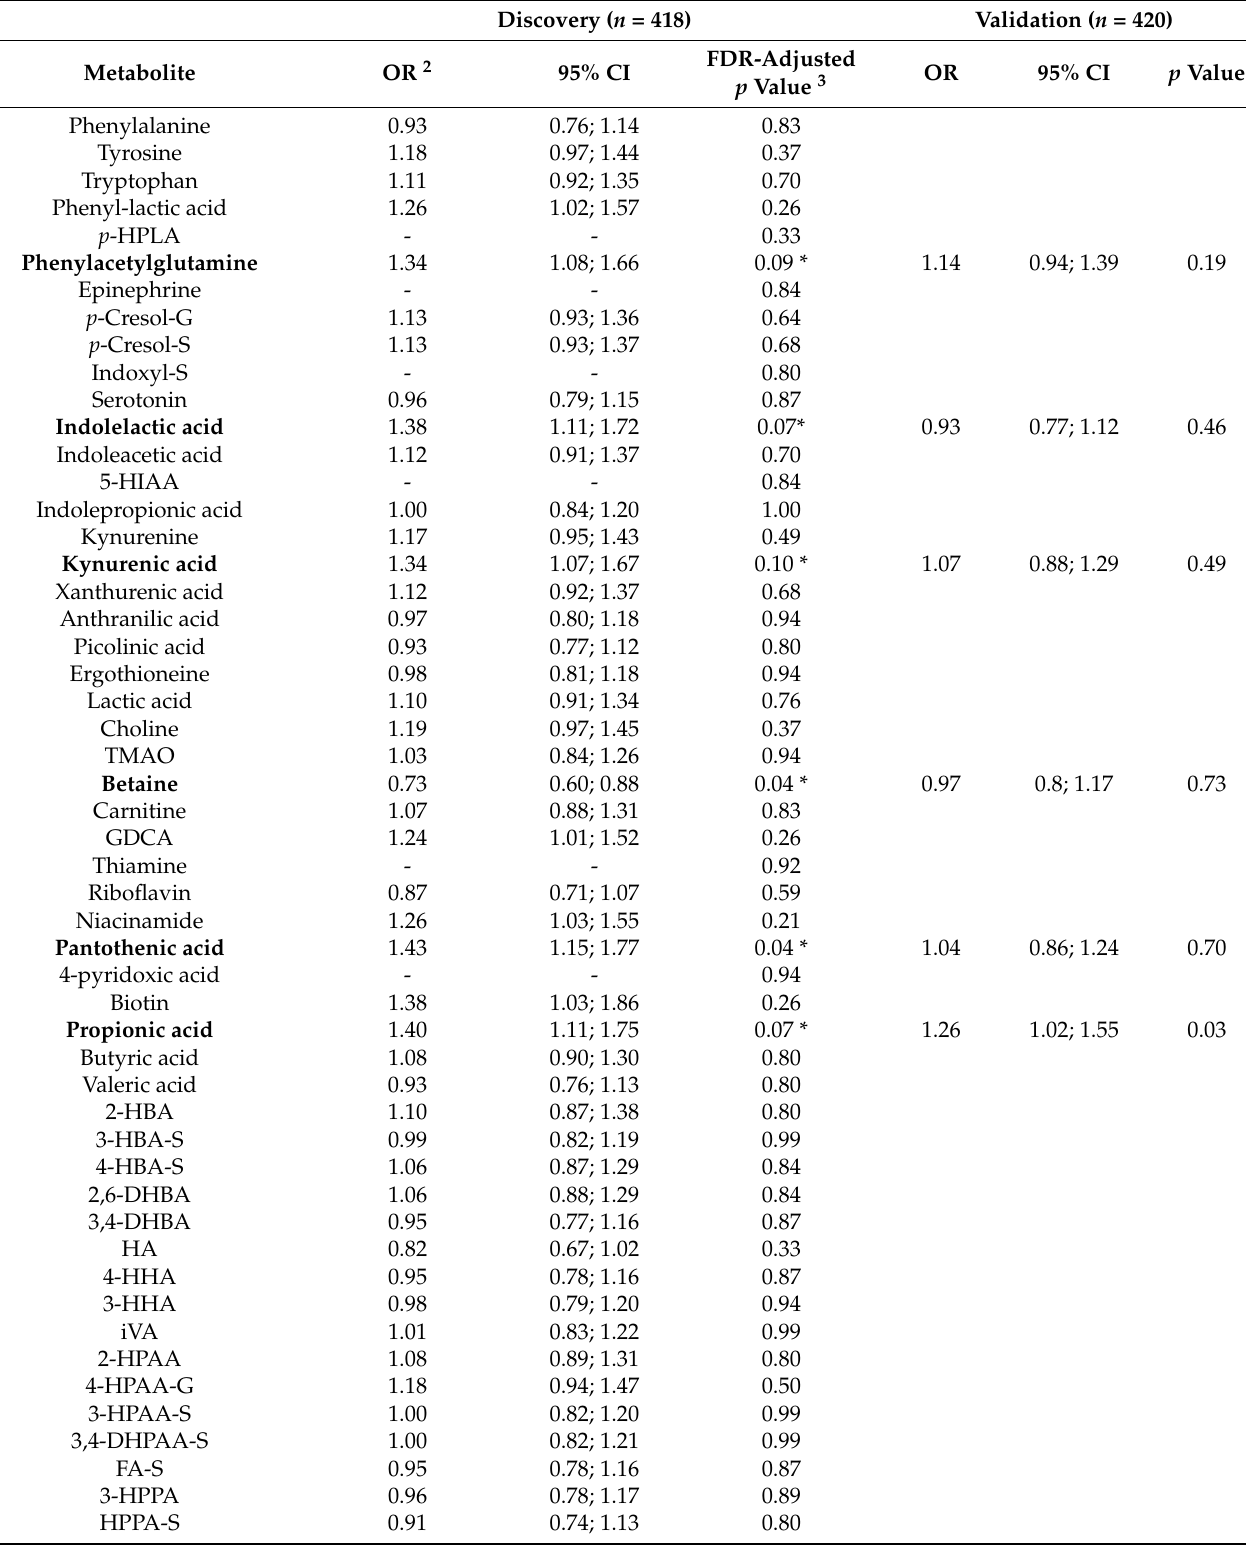
Table 2. Associations 1 between standardized concentrations of food- and gut microbiota-derived metabolites in serum and the odds of subsequent cognitive decline over 12 years in discovery and validation